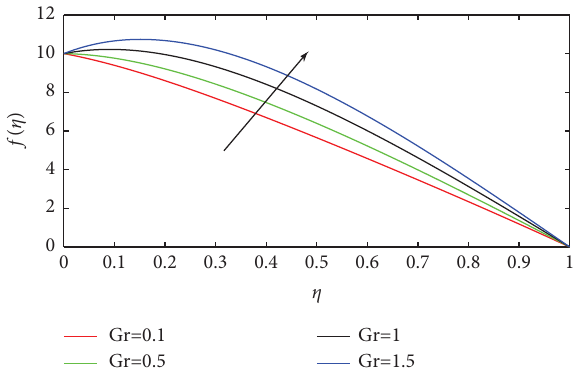
Figure 4: Velocity profles for the diferent values of Gr.